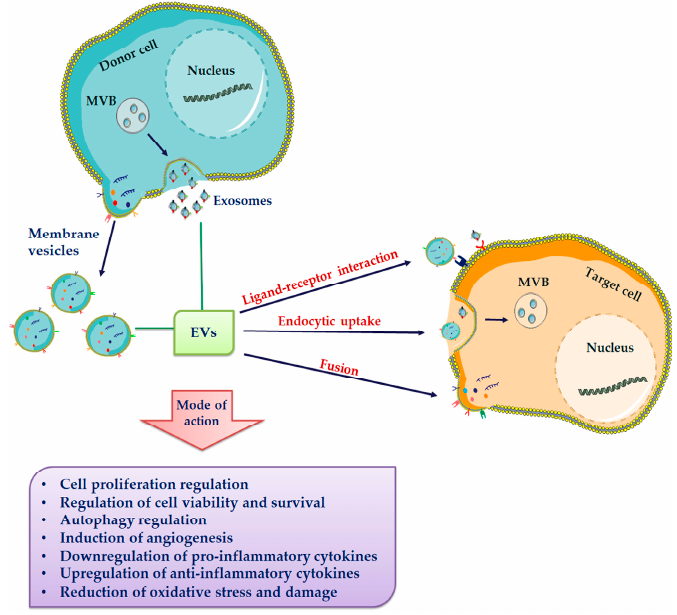
Figure 2. Extracellular vesicle (EVs) release and uptake by target cells. EVs, including exosomes and